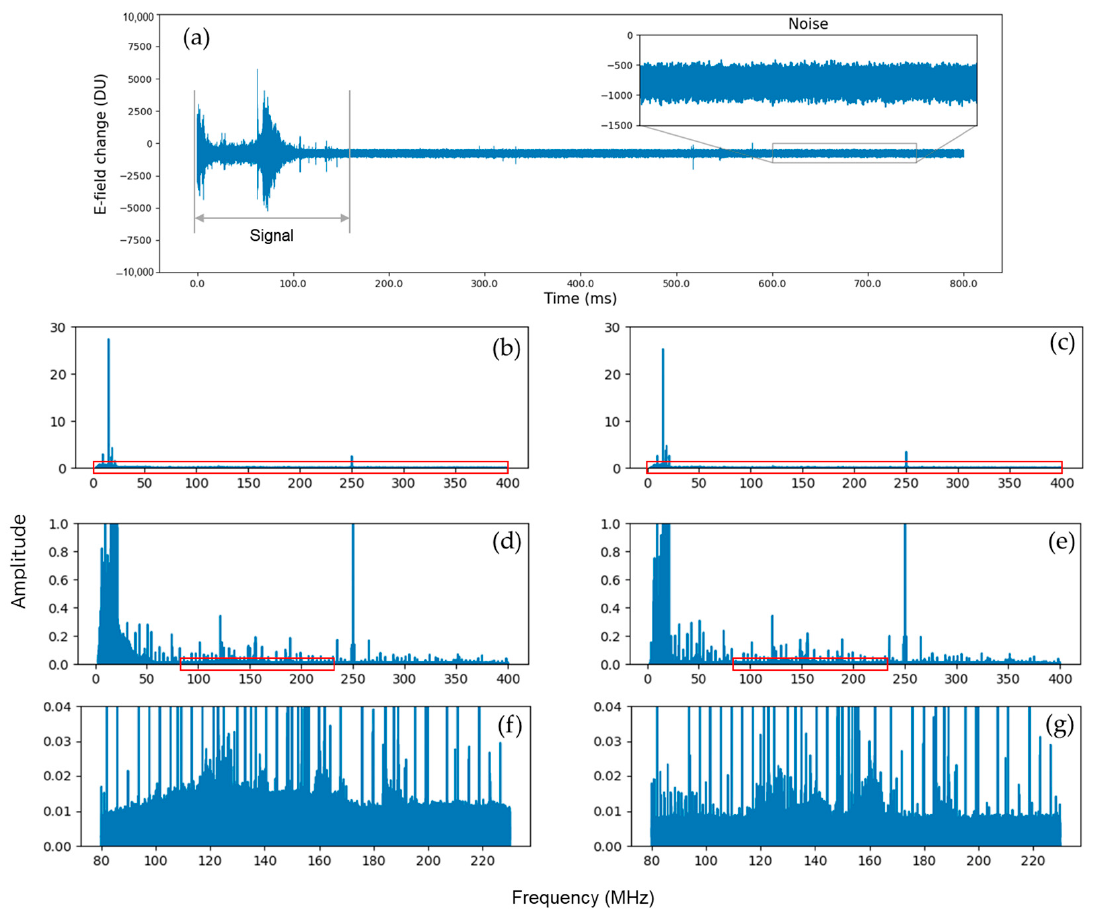
Figure 7. Example waveform and frequency spectrum of the raw lightning data recorded at one channel of InLMA. ( a ) Signal waveform and background noise; ( b , d , f ) Frequency spectrum of the flash signal; ( c , e , g ) Frequency spectrum of the